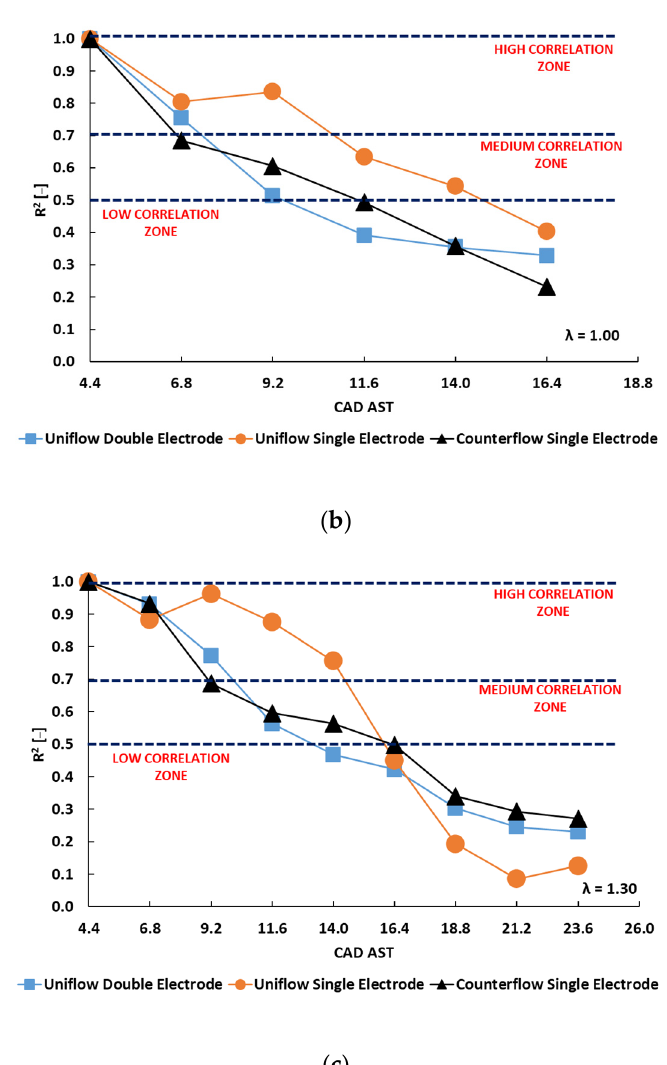
Figure 12. ( a ) Coefficient of determination R 2 of linear fit between the Y ‐ axis displacement of kernel and flame at CA5 for different orientations. ( b , c ): Evolution of R 2 (along the Y axis) during the early stages of the combustion process for different spark orientations at 1.00 ( middle ) and 1.30 AFR rel ( bottom ).